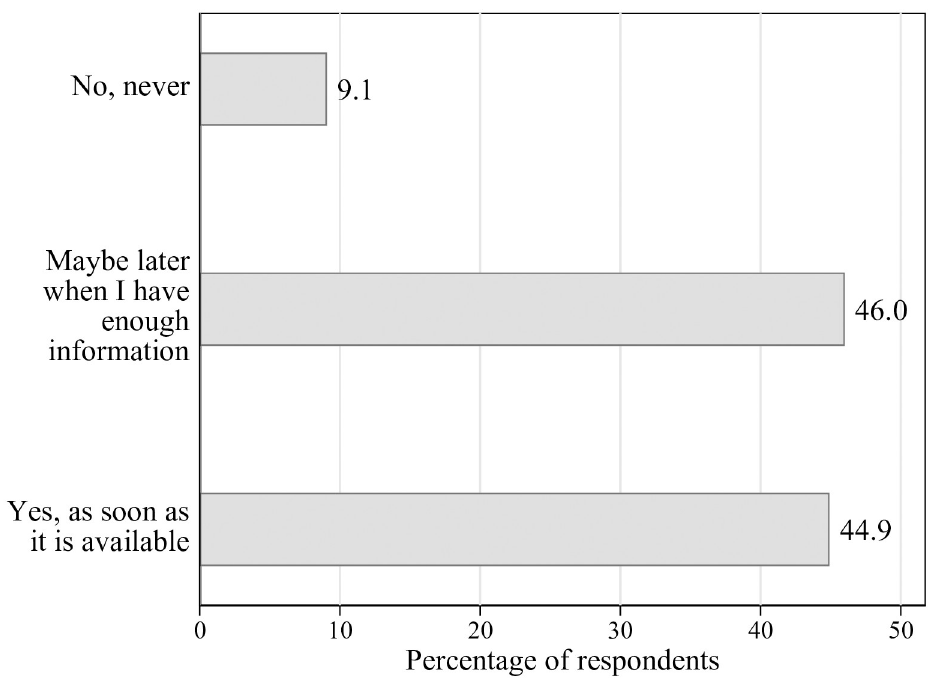
Fig 1. Willingness to get vaccinated. Survey question (n = 915): “Assuming that the COVID-19 vaccination is free of charge and approved in Switzerland, would you like to be vaccinated?”.